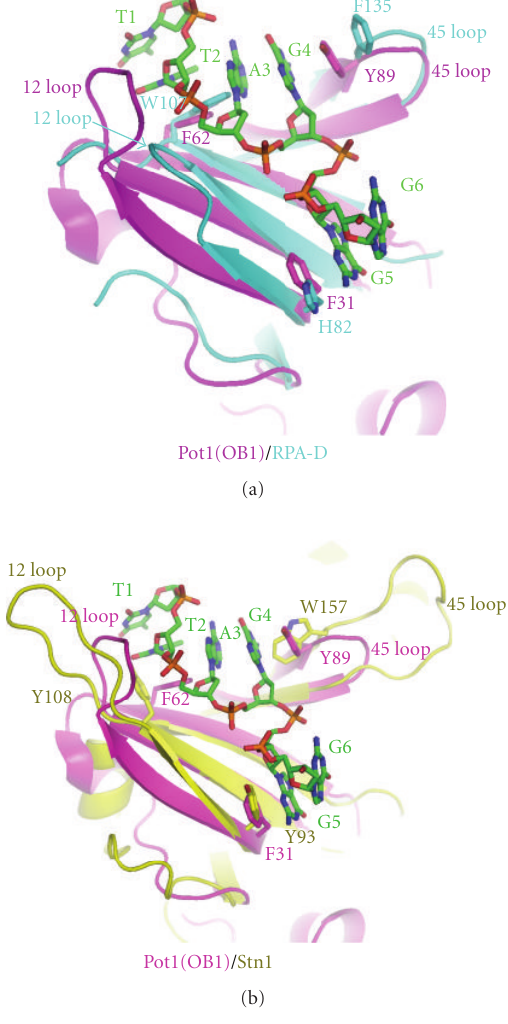
Figure 7: Comparison and prediction of ssDNA-binding sites. (a) Superposition of RPA-D (cyan) of with Pot1 (magenta). Alpha carbons from residue ranges of RPA2 residues, 130–142, 74–83, and 101–107 were superimposed with Pot1 (OB-1), 84–96, 23–32, and 56–62, respectively, with an RMSD of 0.8 ˚A. Pot1 residues 6–145 and RPA residues 43–171 are indicated as ribbons. DNA bases 1-6 (5 (cid:2) - TTAGGG-3 (cid:2) ) from the Pot1 crystal structure are shown in green. (b) Superposition of Stn1 (yellow) with Pot1 (magenta). Alpha carbons from residue ranges 152–155, 122–127, 110–115, and 87– 94 of Stn1 were aligned with residues 84–89, 56–61, 45–50, and 25– 32 of Pot1, respectively, with an RMSD of 1.9 ˚A. Aromatic residues involved in stacking interactions from all proteins are shown as sticks. The superpositions of PDB entries 1XJV, 1QUQ, and 3KF8 were performed using ccp4i (LSQMK) [11] and displayed with Pymol